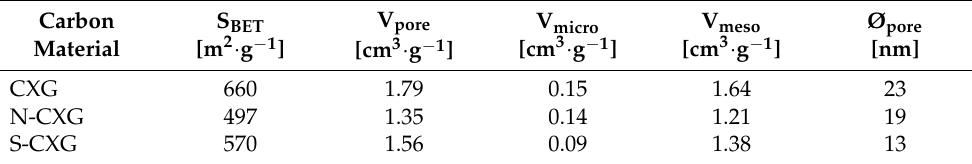
Table 1. Textural features of CXG, N-CXG and S-CXG determined from N 2 physisorption.